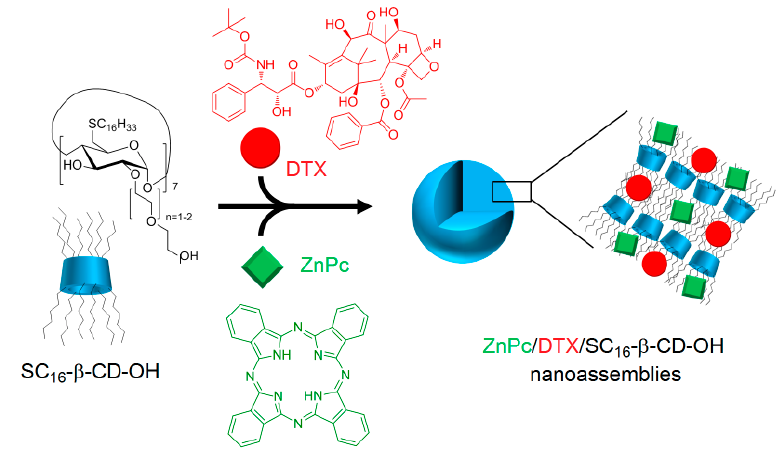
Figure 40. Molecular structure of SC 16 - β -CD-OH, ZnPc, docetaxel (DTX), and corresponding ZnPc/DTX/SC 16 - β -CD-OH nanoassembly. Adapted from Conte; Scala; Siracusano; Sortino; Pennisi; Piperno; Miro; Ungaro; Sciortino; Quaglia; Mazzaglia [167].